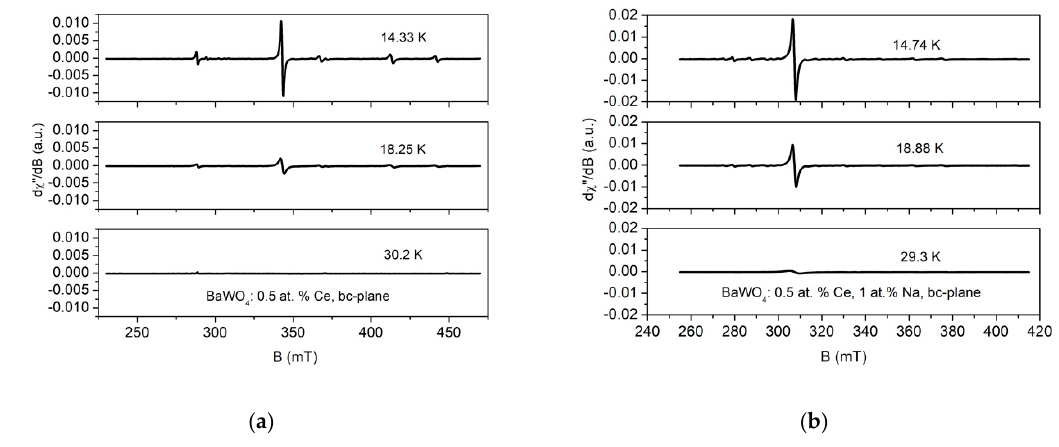
Figure 4. EPR spectra of BaWO 4 :0.5 at. Ce ( a ) and BaWO 4 :0.5 at. % Ce, 1 at. % Na ( b ) for several